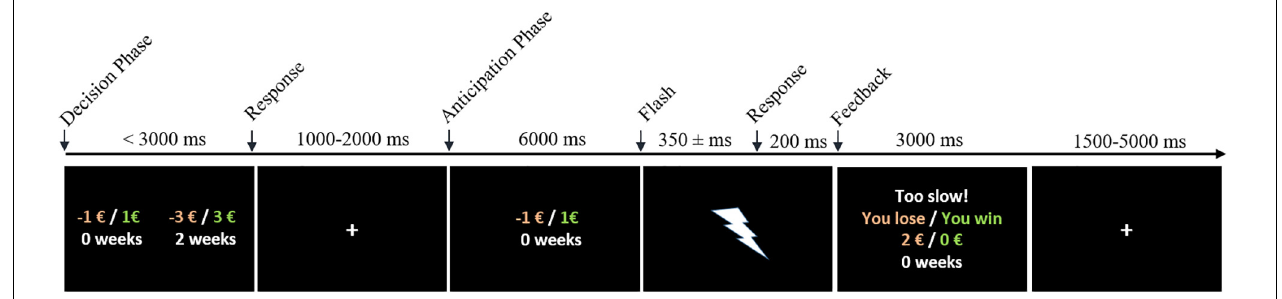
FIGURE 1 | Experimental design. Arrows indicate onsets of GLM regressors. Participants had to choose between two losses (red) or two wins (green) within 3 seconds ( decision phase ). The chosen outcome was then cued for 6 seconds ( anticipation phase ), after which a short flash (50 ms) occurred. If participants pressed the button within an adaptive response window (starting with 300 ms), they received the outcome. If not, the win was reduced to €0 (reward condition) and losses were doubled (loss condition), as presented in the